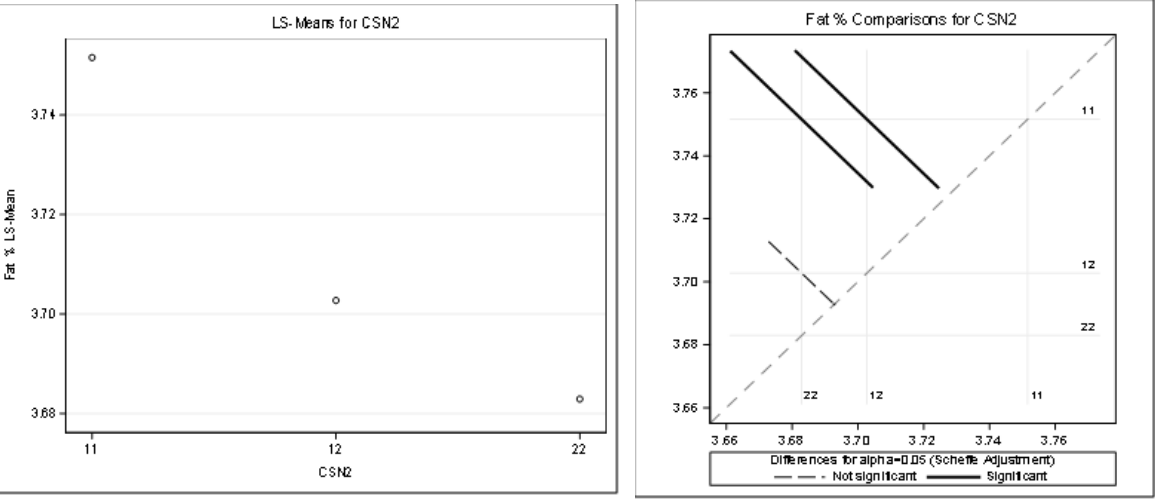
Figure 6. Least squares means and multiple comparisons for fat %.